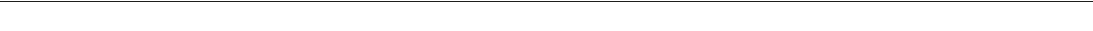
Fig. 1 Frequency of responding NK cells across multiple stimulation conditions. a Top row: overall successive gating strategy demonstrates initial broad gating on forward and side scatter to include large lymphocytes. Forward area and height are used to discriminate single cells followed by identi fi cation of viable cells. Monocytes and B cells are excluded using CD14 and CD19, and T cells are excluded using CD3 and CD4. Bottom row: CD56 and CD16 are used to identify NK cells and changes in CD16 expression across stimulation conditions. Black gate is the total NK population and red gate is CD56 dim population. b A univariate analysis of the frequency of CD107a, INF- γ , TNF, granzyme B, perforin, and eomesodermin expression from the total NK cell population as well as CD57 and CD8 expression are shown. c Pie charts of classic Boolean analysis of fi ve functional markers measured (CD107a, IFN- γ , TNF, granzyme B, and perforin). Comparison of pies and nonparametric partial permutation tests (Monte Carlo simulation) are performed to determine statistical signi fi cance between pies ( p -value < 0.0001) 69 . d Graph of classic Boolean analysis of fi ve functional markers measured. Four healthy subjects from four independent experiments in each stimulation condition are included. CD107a, IFN- γ , and TNF are mock subtracted (i.e., stimulated condition − unstimulated result). Black bars represent the standard error mean (SEM) for each stimulation condition calculated as the variance of the sampling distribution obtained, equal to the variance of the population divided by the sample